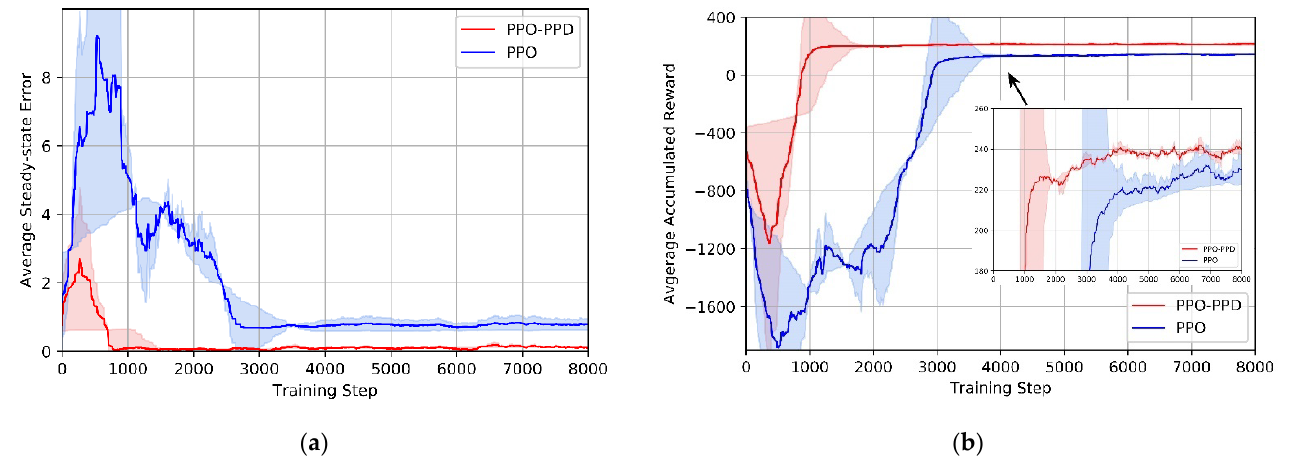
Figure 8. ( a ) Average steady-state error in the evaluation of policies learned by PPO-PPD and PPO. ( b ) Average accumulated reward in the evaluation of policies learned by PPO-PPD and PPO.